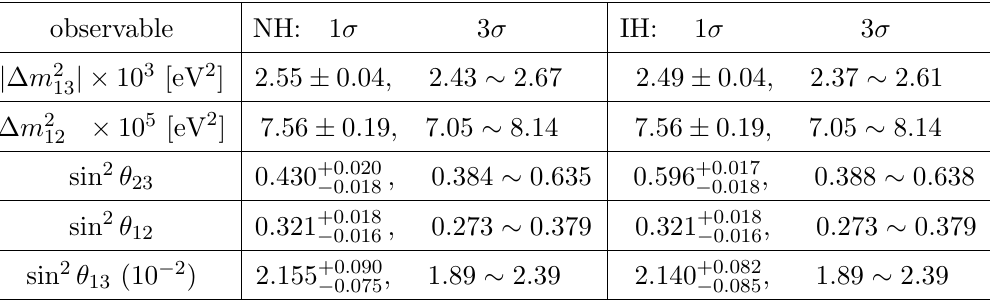
Table 1 . 1 (cid:27) and 3 (cid:27) ranges of the global analysis of the neutrino oscillation experimental data for NH and IH, respectively